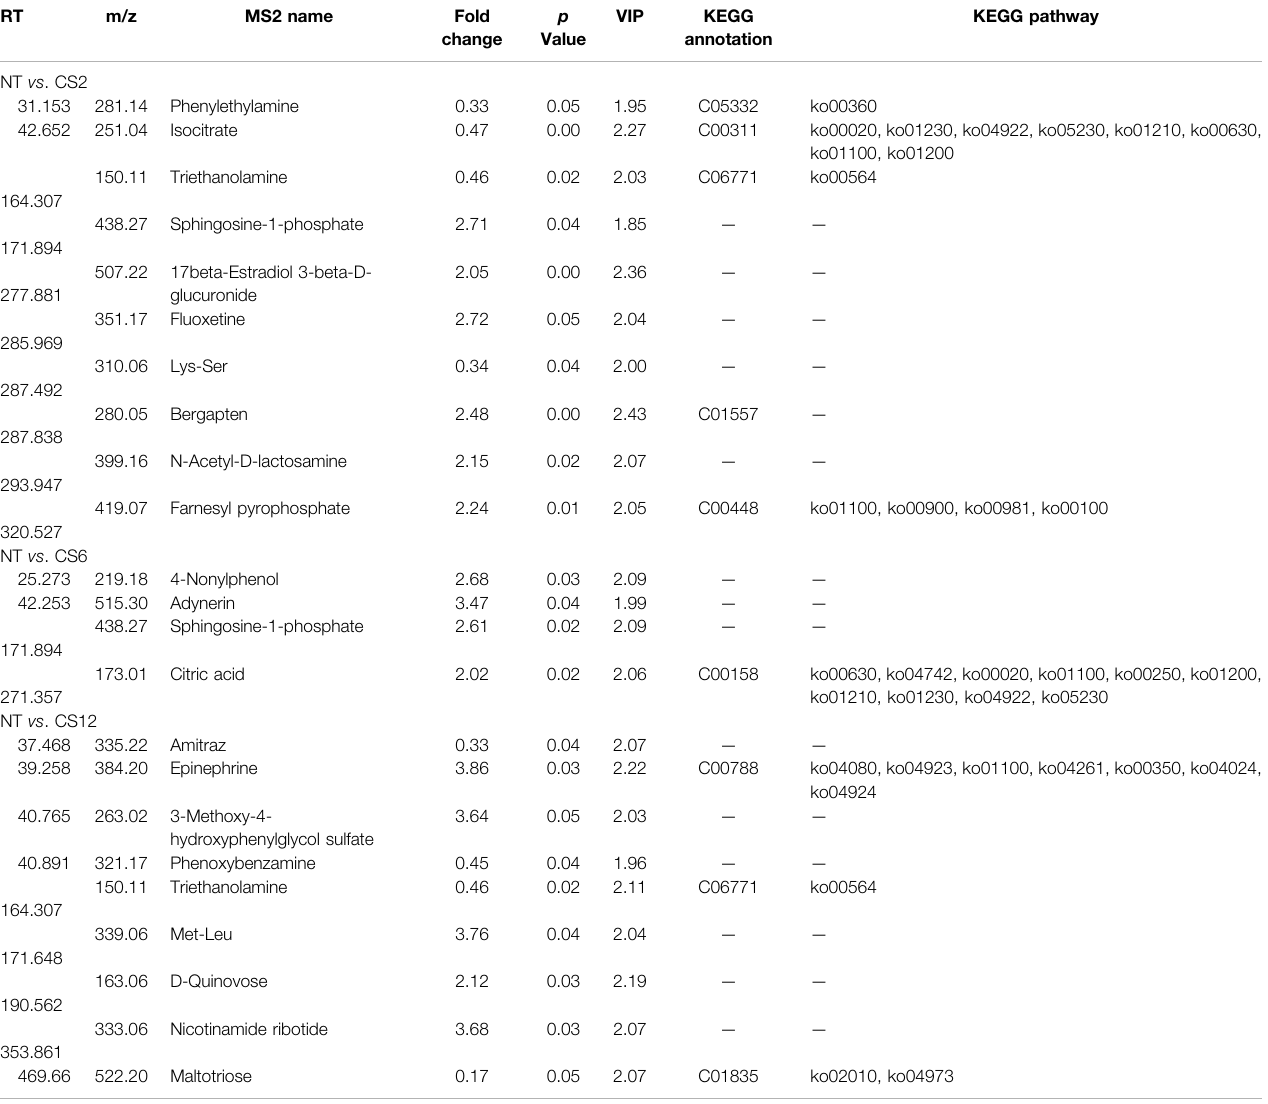
TABLE 1 | Differential metabolites observed in the